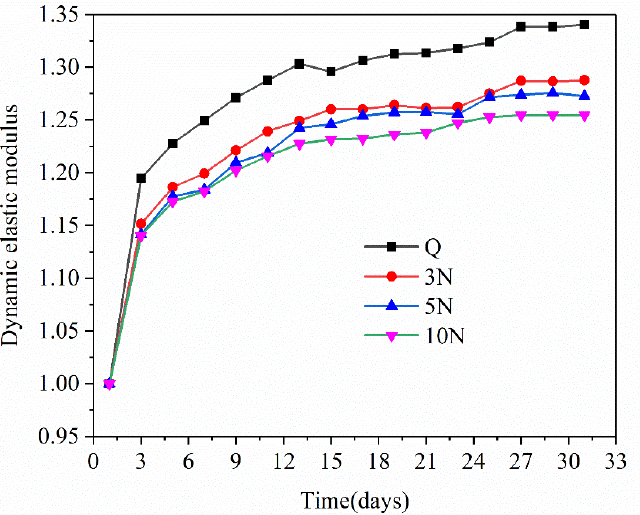
Figure 2. Change of dynamic elastic modulus of concrete with different sodium sulfate content with time.